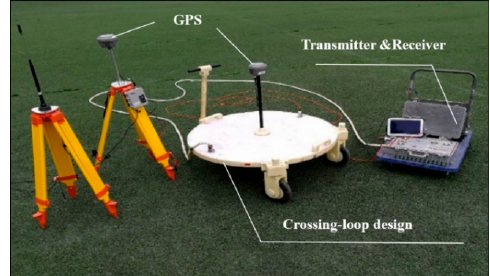
Figure 10. The cross-loop design and the FCTEM60 transient electromagnetic system.